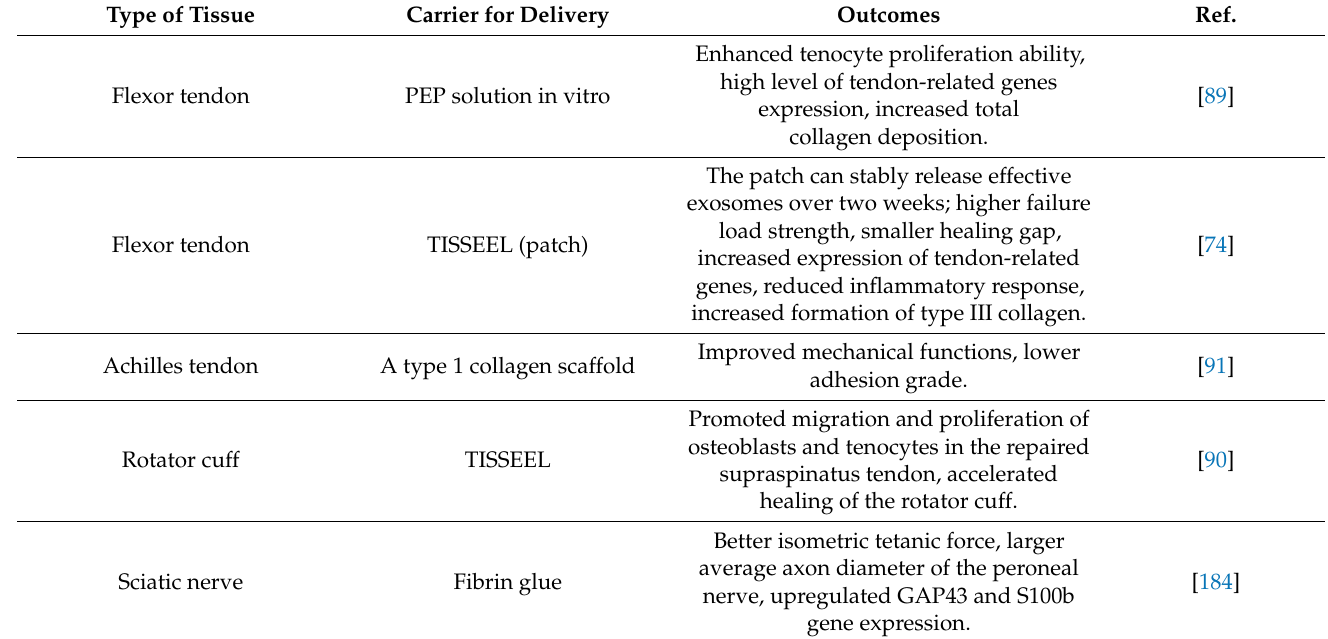
Table 1. The application of the purified exosome product in soft tissue repair and regeneration. Type of Tissue Carrier for Delivery Outcomes Ref.